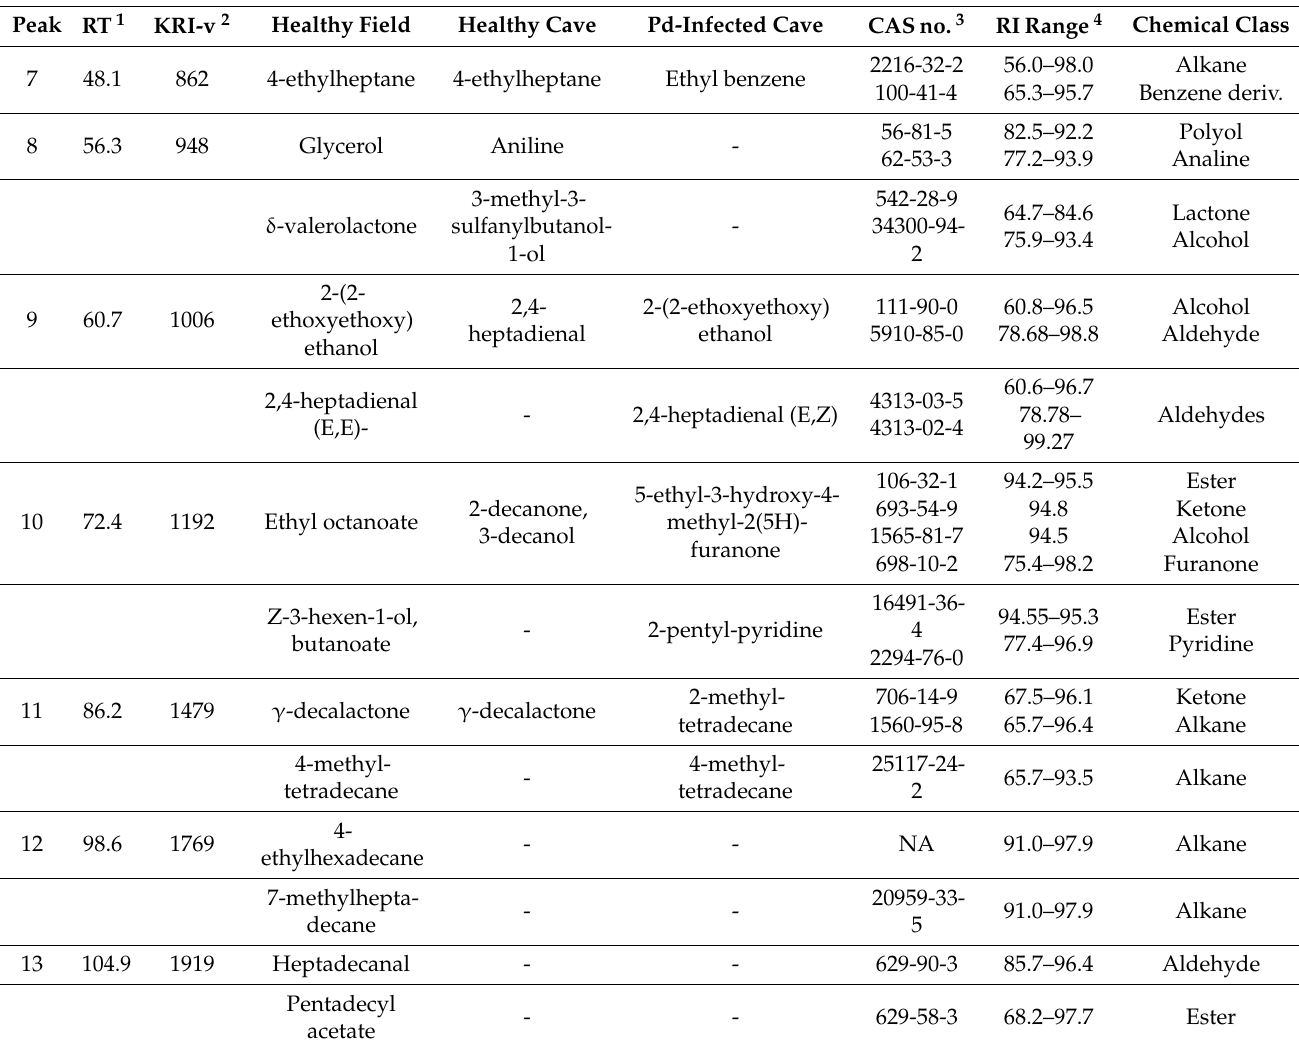
Table 6. Cont. Tentative Identity of P. subflavus VOC